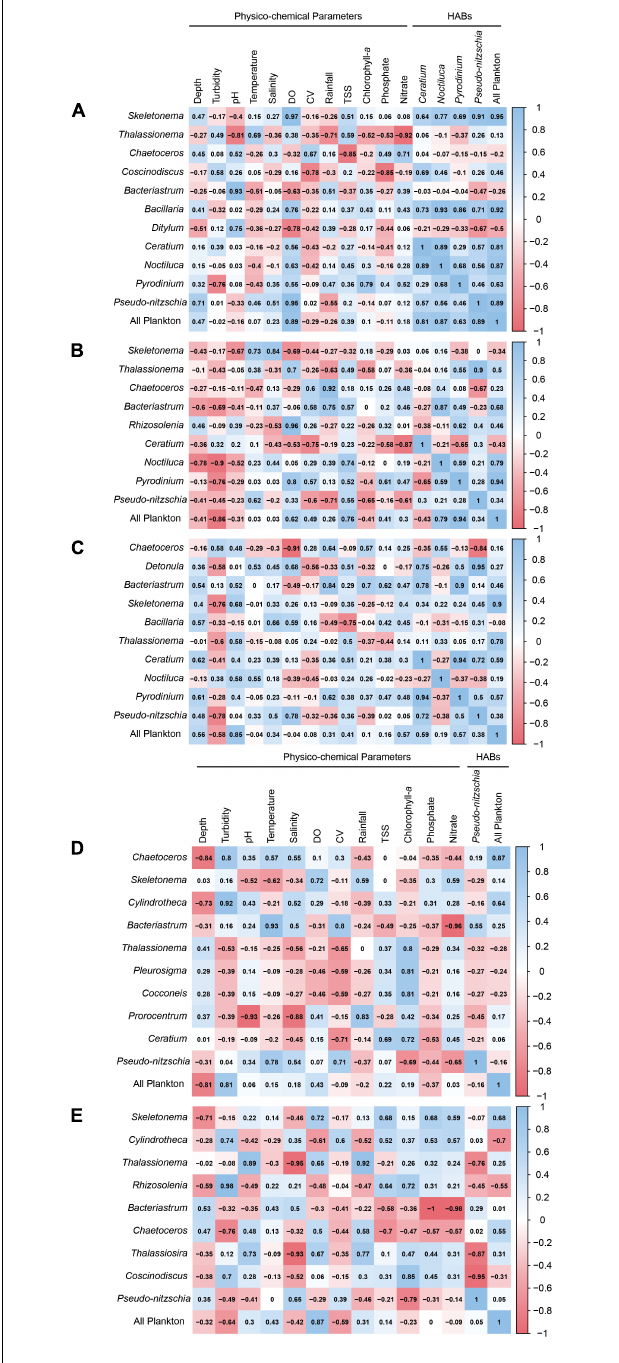
FIGURE 6 | Correlogram of the dominant phytoplankton groups, physico-chemical parameters, and dominant HAB-vectors in (A) Cambatutay, (B) Irong-Irong, (C) Villareal, (D) Carigara, and (E) Biliran Bays. The correlogram shows correlation coefficients for all pairs of variables. Positive correlations are displayed in blue and negative correlations in red. The intensity of the color is proportional to the correlation coefficient so the stronger the correlation (i.e., the closer to –1 or 1), the darker the boxes. The color legend on the right-hand side of the correlogram shows the correlation coefficients and the corresponding colors. The physico-chemical parameter legend: DO (dissolved oxygen), CV (current velocity), and TSS (total suspended